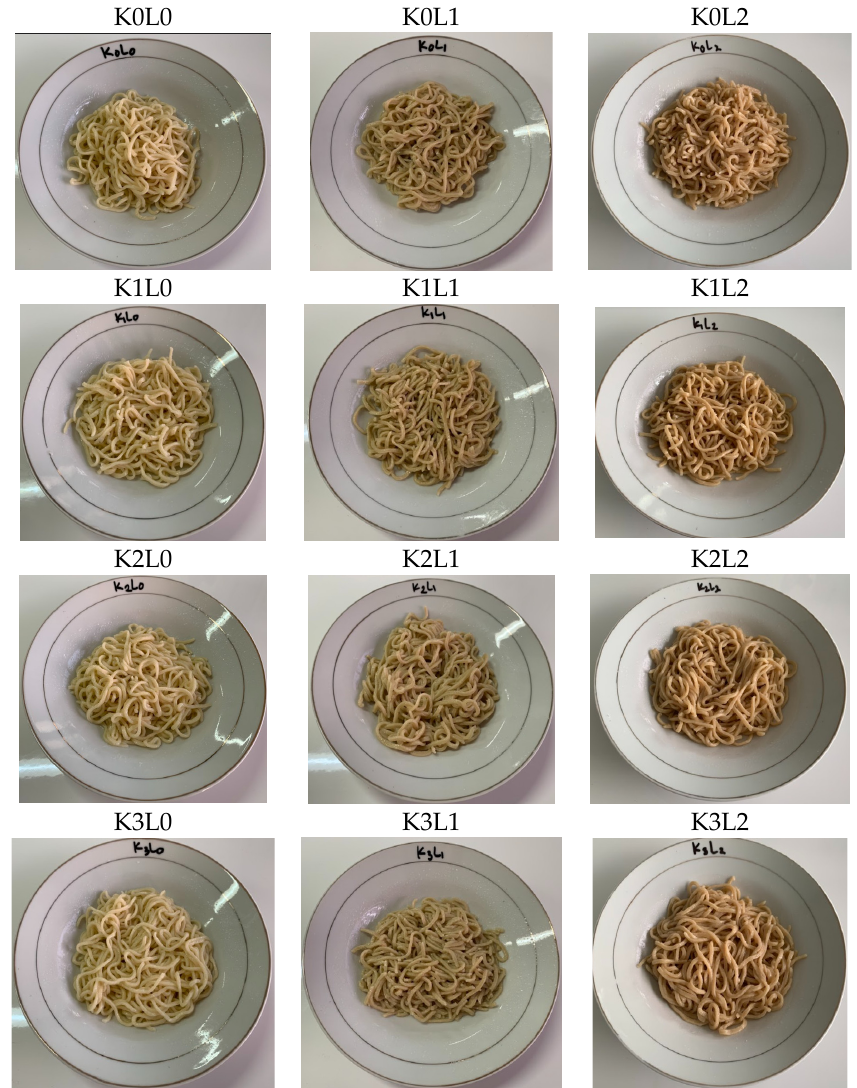
Figure 1. Stink lily noodles. Note that K0 = wheat flour: stink lily flour: κ -carrageenan = 80:20:0, K1 = wheat flour: stink lily flour: κ -carrageenan = 80:19:1, K2 = wheat flour: stink lily flour: κ -carrageenan = 80:18:2, K3 = wheat flour: stink lily flour: κ -carrageenan = 80:17:3, L0 = concentra- tion of the hot water extract from the pluchea leaf tea = 0%, L1 = concentration of the hot water ex- tract from the pluchea leaf tea = 15%, L2 = concentration of the hot water extract from the pluchea leaf tea = 30%. Table 3. Color, moisture content, swelling index, cooking loss, and tensile strength of the stink lily noodles.